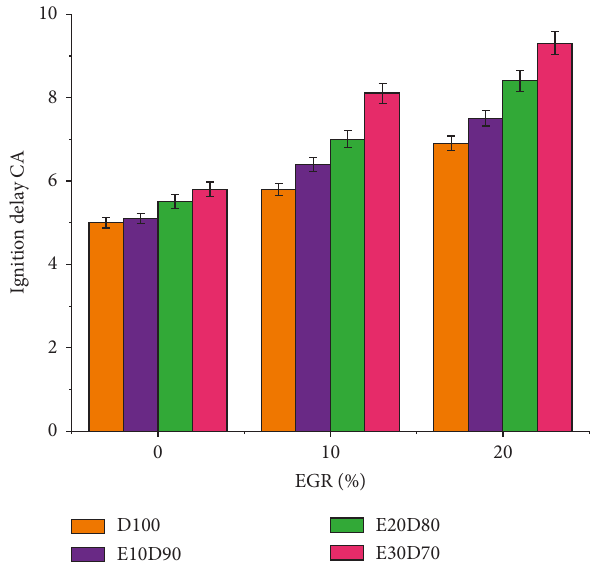
Figure 9: Variation in ID with EGR (0%, 10%, and 20%) at 60% load.